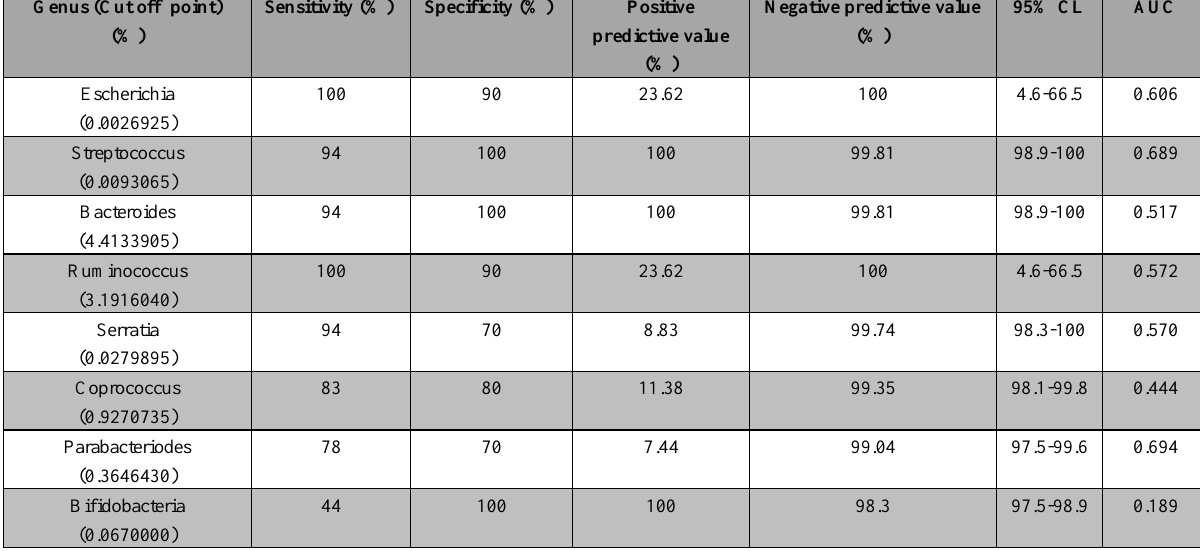
Table 4. Sensitivity, Specificity, and predictive values of the gut microbiome and genus for the prediction of T2DM. Genus (Cut off